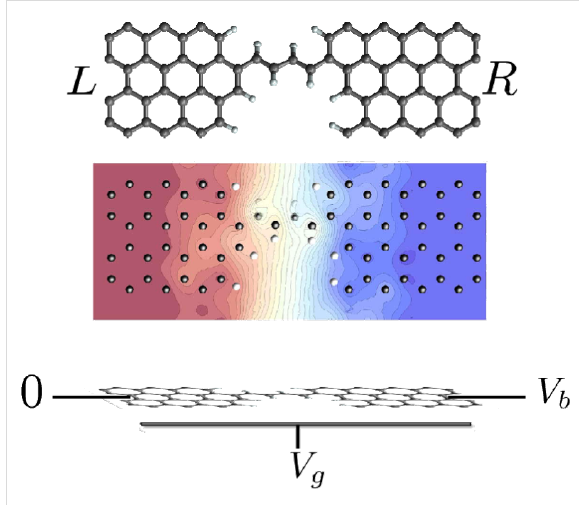
Figure 1: The system considered in the present study is a four-atom carbon chain bridging two graphene electrodes. The dangling bonds are passivated by hydrogen atoms. In addition to the bias applied between the left ( L ) and right ( R ) electrodes ( V b ), a gate potential ( V g ) can also be applied perpendicular to the graphene surface. The center panel shows the calculated contour plot of the electrostatic-potential drop across the junction at V g = 0 V, and V b = 1 V. The equal drop at the left and right electrodes reflects the electron–hole symmetry for V g = 0 V [40].